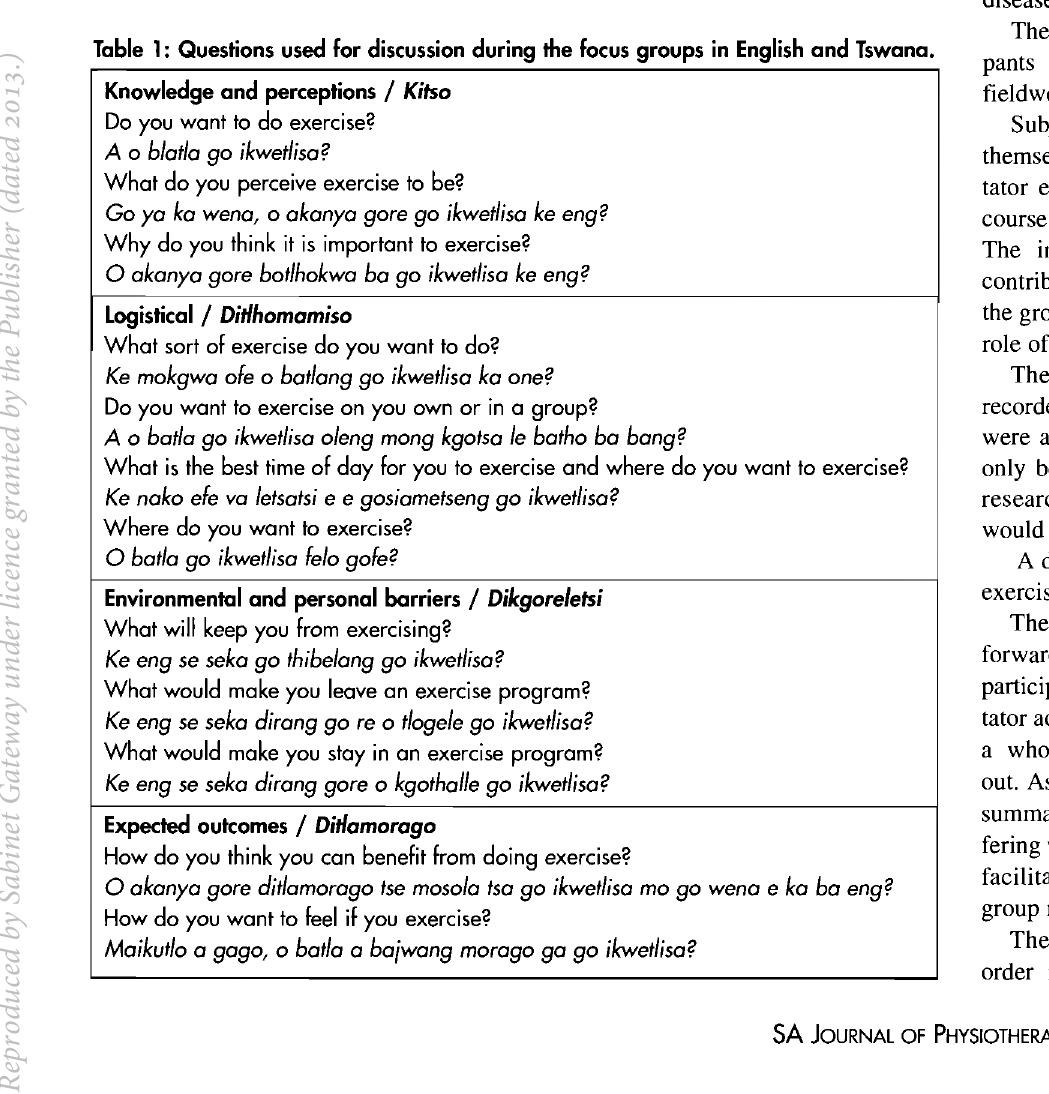
Table 1: Questions used for discussion during the focus groups in English and